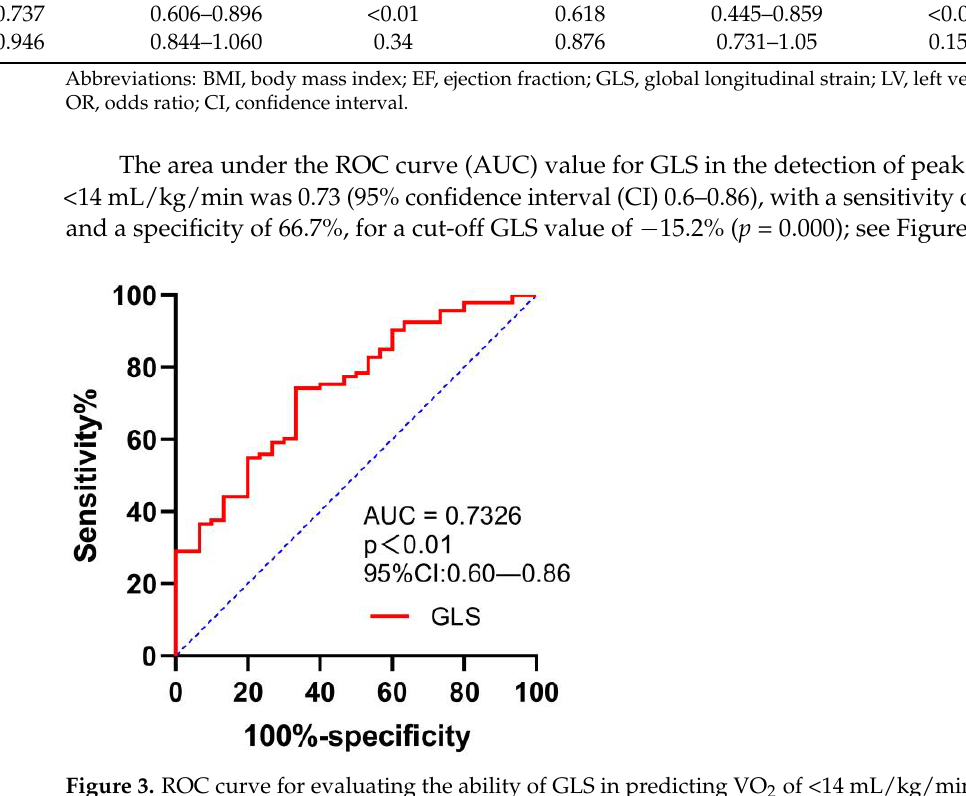
Figure 3. ROC curve for evaluating the ability of GLS in predicting VO 2 of <14 mL/kg/min.